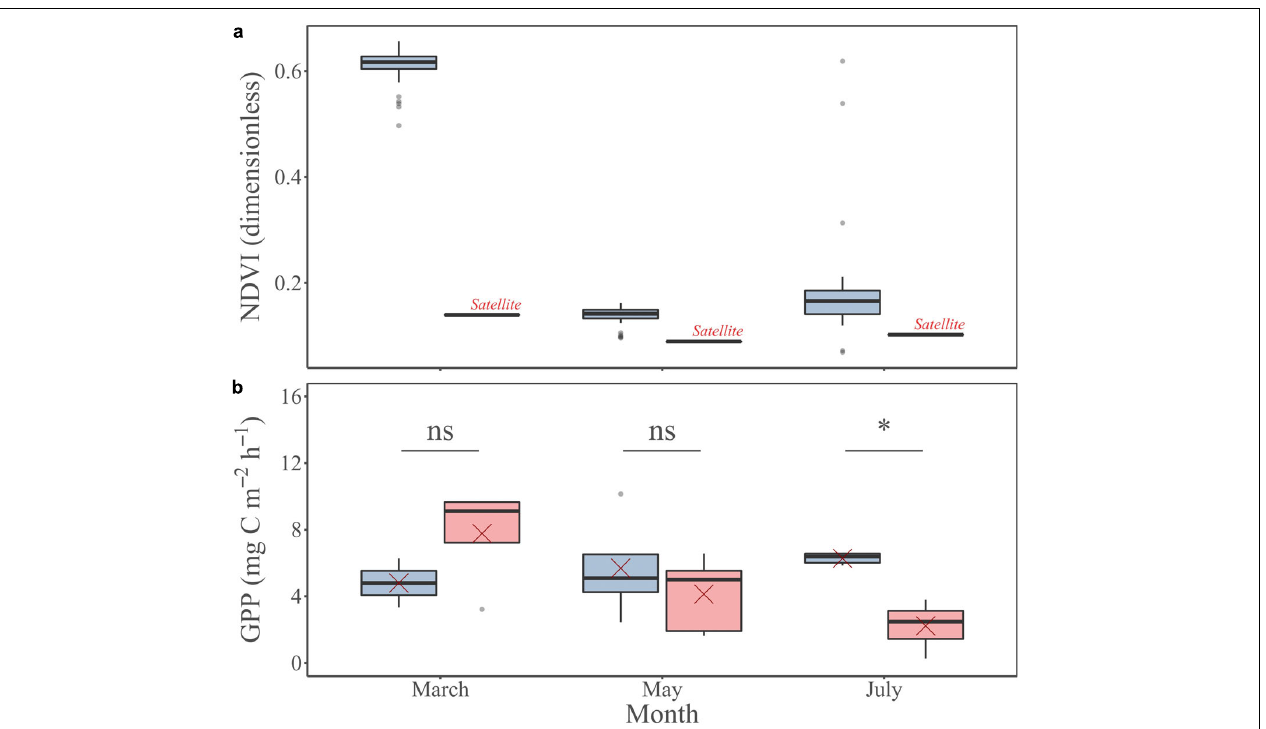
FIGURE 9 | MPB-specific NDVI (a) and GPP (b) measured in situ (blue) and remotely sensed (pink) at the study site for the three investigated periods: March, May, and July. Red crosses correspond the mean values for the corresponding period. Mann Whitney test, p -value: ns, p > 0.01; * p ≤ 0.01; ** p ≤ 0.001; *** p ≤ 0.0001.